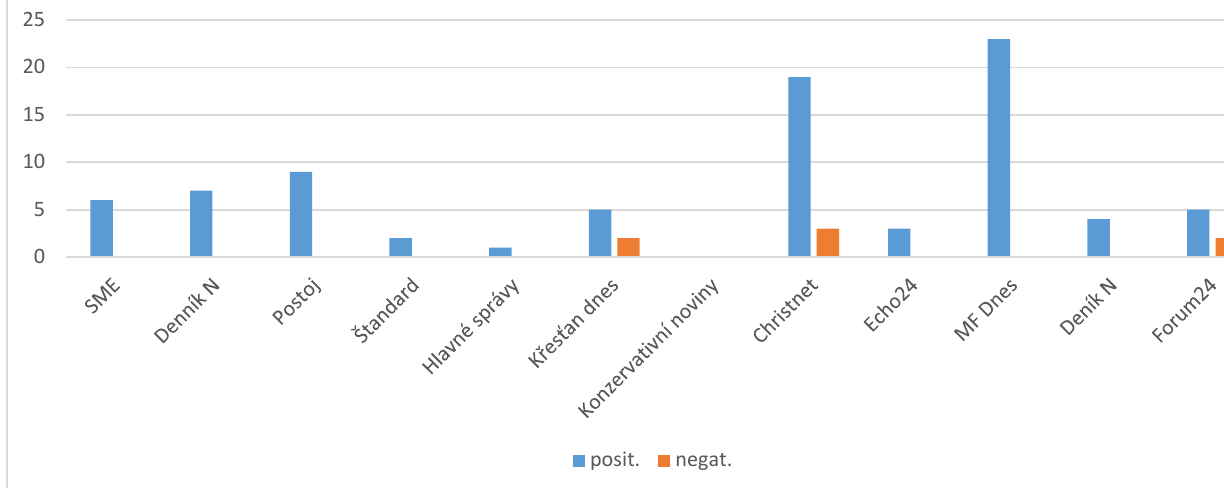
Figure 3. Occurrences of ‘opportunity’ as an argument (A2).